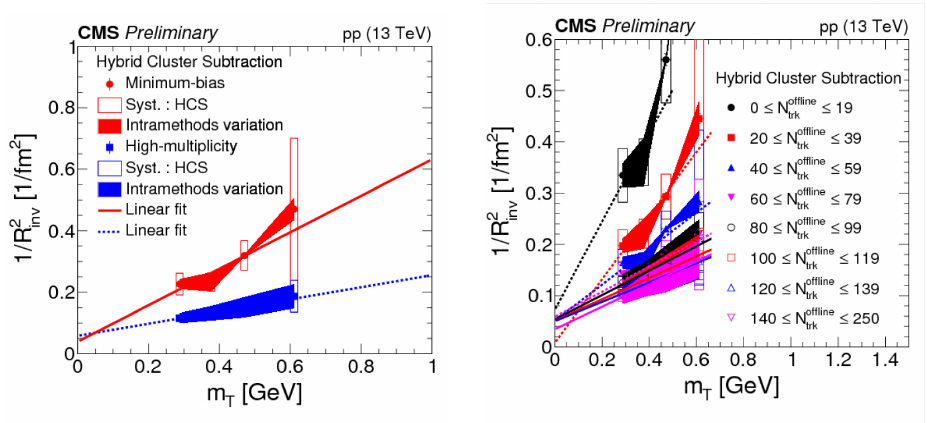
as a function of for the HCS method. The MB range corresponds Fig. 4. 𝑜𝑜𝑜𝑜𝑖𝑖2 to and the HM one, to . Statistical uncertainties are 𝜋𝜋2 2 1/ 𝑅𝑅 𝑚𝑚 𝑇𝑇 = �𝑚𝑚 + < 𝑘𝑘 𝑇𝑇 > represented by error bars, systematic uncertainties related to the HCS method are shown as open boxes 𝑡𝑡𝑡𝑡𝑡𝑡𝑜𝑜𝑜𝑜𝑜𝑜𝑜𝑜𝑜𝑜𝑜𝑜𝑜𝑜 𝑡𝑡𝑡𝑡𝑡𝑡𝑜𝑜𝑜𝑜𝑜𝑜𝑜𝑜𝑜𝑜𝑜𝑜𝑜𝑜 0 ≤ 𝑁𝑁 ≤ 79 80 ≤ 𝑁𝑁 ≤ 250 and the relative uncertainties from the intramethods variation are represented by the shaded bands. Only statistical uncertainties are considered in all the fits